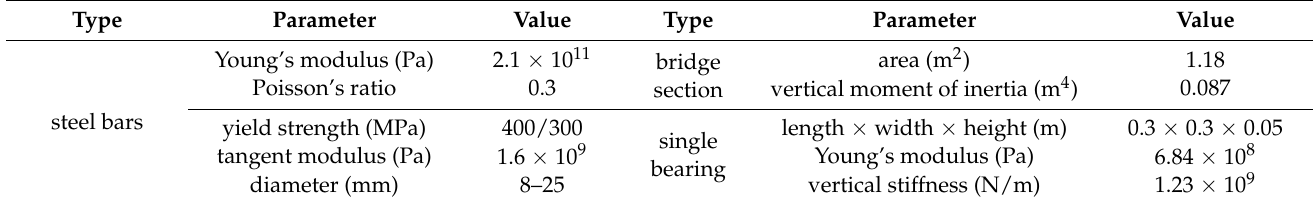
Table 3. Calculation parameters of the model under